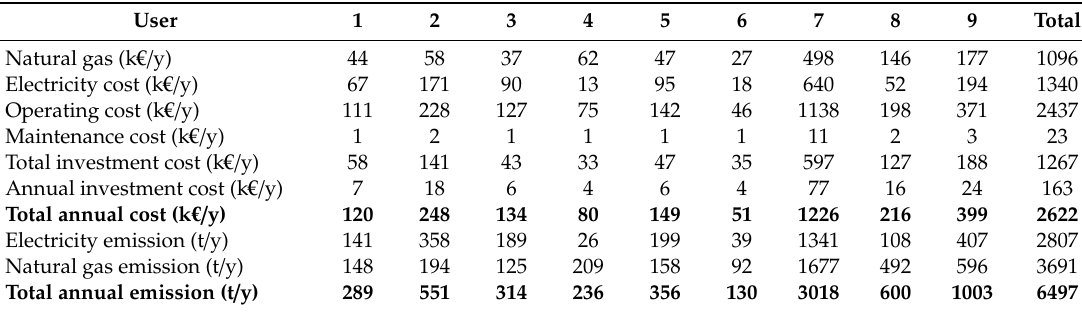
Table 4. Economic and environmental optimization of the conventional solution.